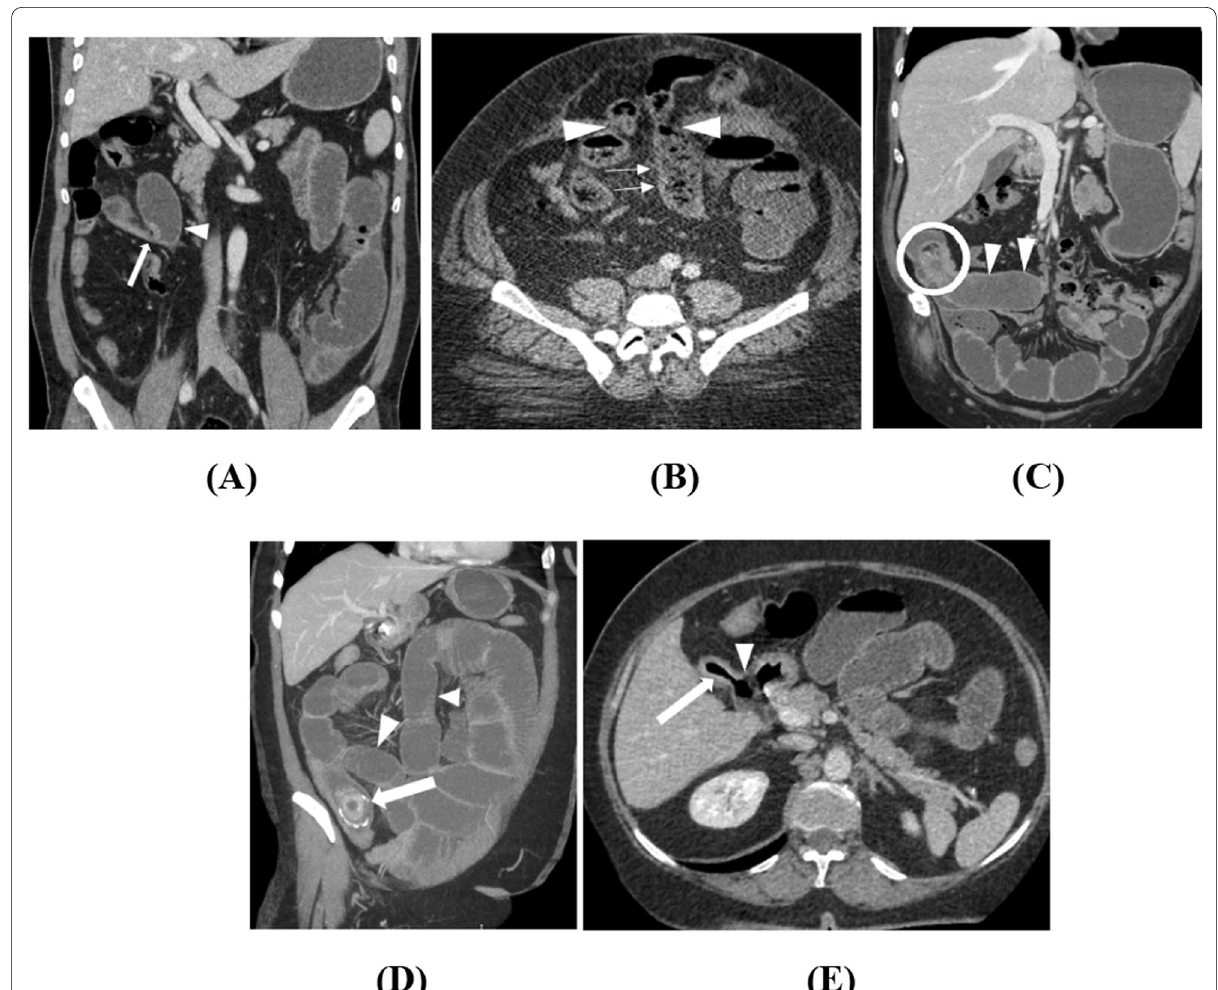
Fig. 4 Different patient diagnosed with small bowel obstruction presented with acute abdominal pain, vomiting and constipation. A Coronal CT in venous phase for patient diagnosed with adhesive intestinal obstruction showing proximally dilated bowel loops (white arrow head) and the site of transition zone of adhesive band (white arrow). B Axial CT in arterial phase for patient diagnosed with recurrent obstructed para-umbilical hernia showing hernial defect (white arrow head) and proximal dilated bowel loops showing intestinal feces sign (white arrow). C Coronal oblique CT in venous phase with MPR for patient diagnosed with intussusception showing the site of intussuscepted bowel loop (white circle) with the leading point, dilated Meckel’s diverticulum (white arrow heads). D Coronal oblique view CT in venous phase with MPR and MIP for patient diagnosed with gall stone ileus showing the hyperdense gall stone within small bowel loops (white arrow) and proximal dilated bowel loops (white arrow heads). E Axial CT in venous phase for patient diagnosed with gall stone ileus showing gall bladder pneumobilia (white arrow) and cholecysto-duodenal fistula (white arrow